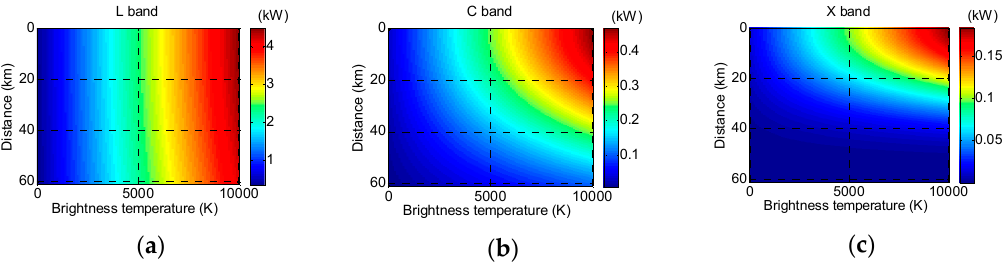
Figure 7. Average transmitted power requirements in GEO SAR systems of different working frequencies. ( a ) L band; ( b ) C band; ( c ) X band, to ensure a SINR better than 10 dB.